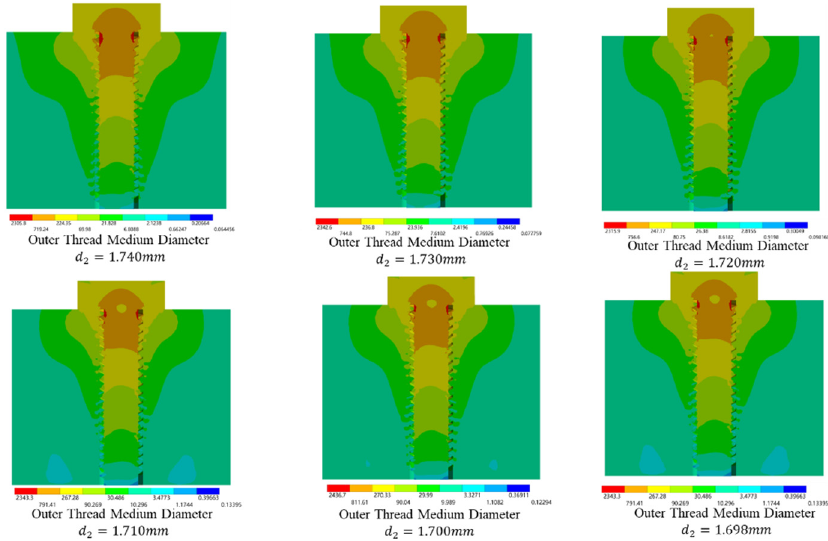
Figure 8. Contact stress distribution under the influence of thread pitch deviation.